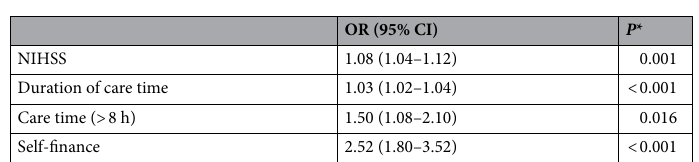
Table 2. Multivariable Models Showing Association Between baseline risk factors and anxiety. *Multivariable adjusted for caregiver’s age, NIHSS, duration of care time, sex, education, care time per day > 8 h, self-finance, relationship to the patients, household income.